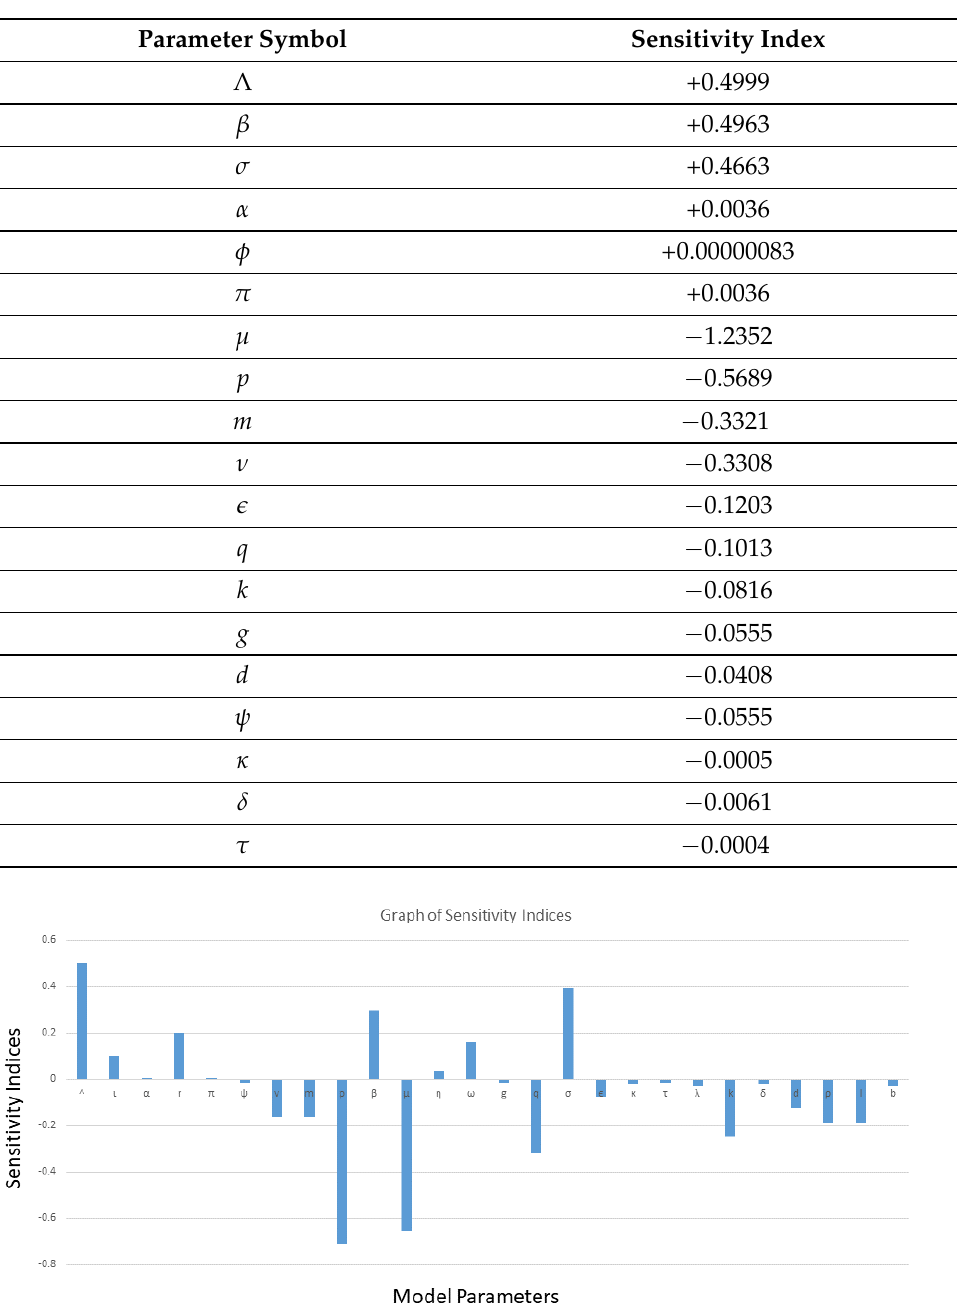
Figure 2. Sensitivity analysis between R 0 and its associated